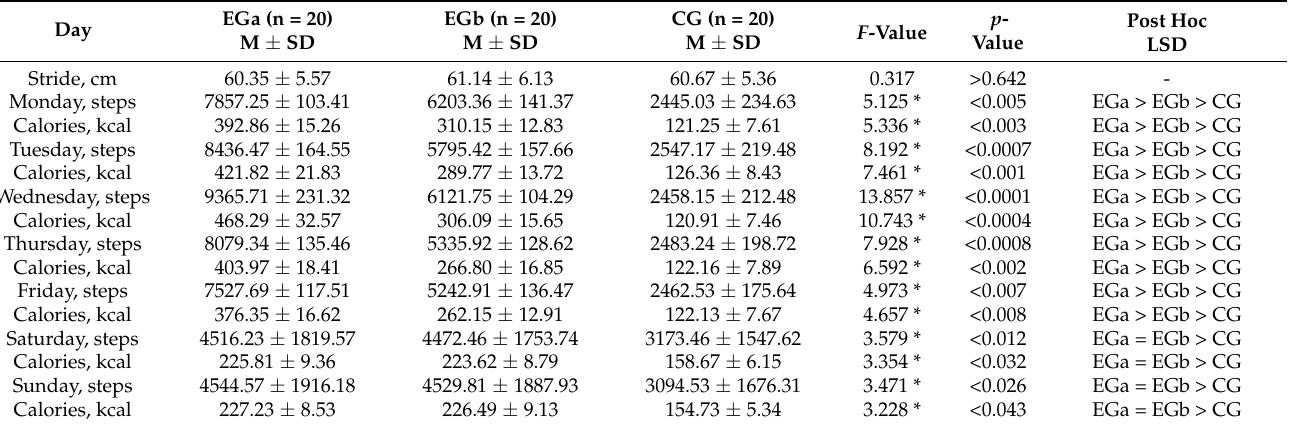
Table 4. Descriptive statistics. One-way ANOVA, and LSD post hoc test of average stride, steps, and calories among the three groups.